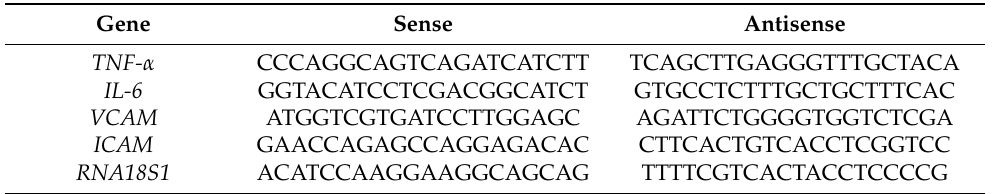
Table 1. Primer sequences for target